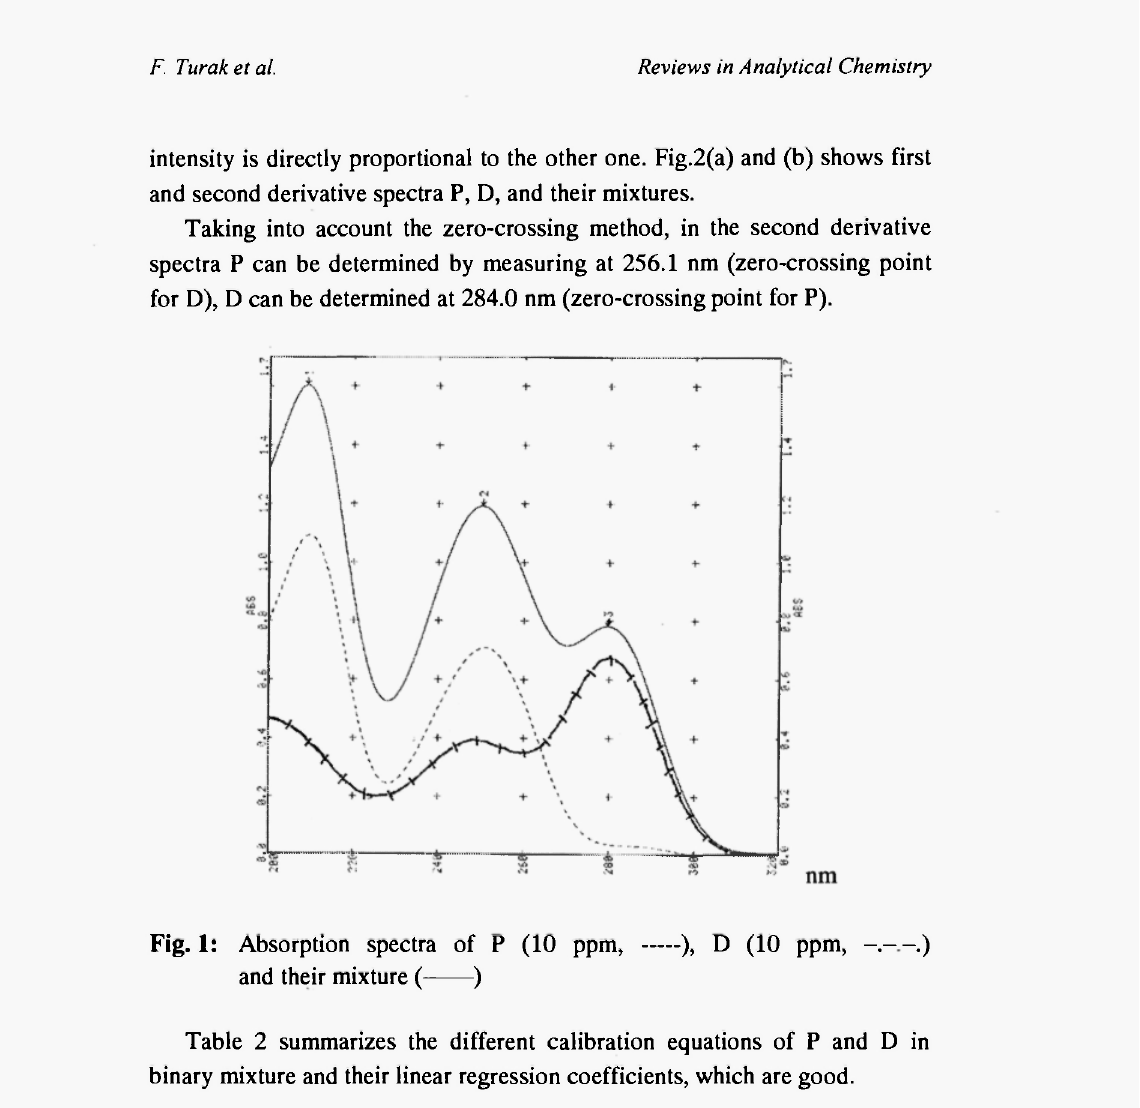
Calibration Equations for the Derivative Spectrophotometry